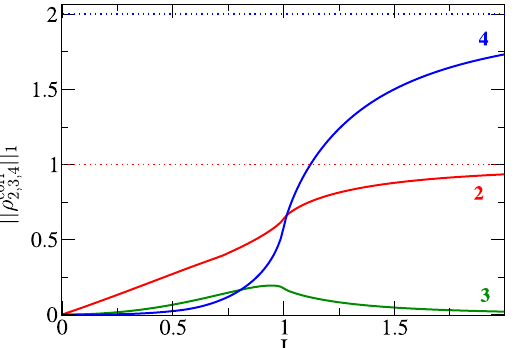
Figure 3. Norms of correlated reduced density operators for two ρ ˆ 2corr (red), three ρ ˆ 3corr (green), and four ρ ˆ 4corr (blue) neighboring spins in the transverse Ising model. At ≈ . J 0 8 , i.e., well before the critical point, the 4-point correlations exceed the 3-point correlations. The 2-point correlations dominate both until the critical point is reached, afterwards the 4-point correlations prevail. The horizontal dashed lines represent the asymptotic values for J → ∞